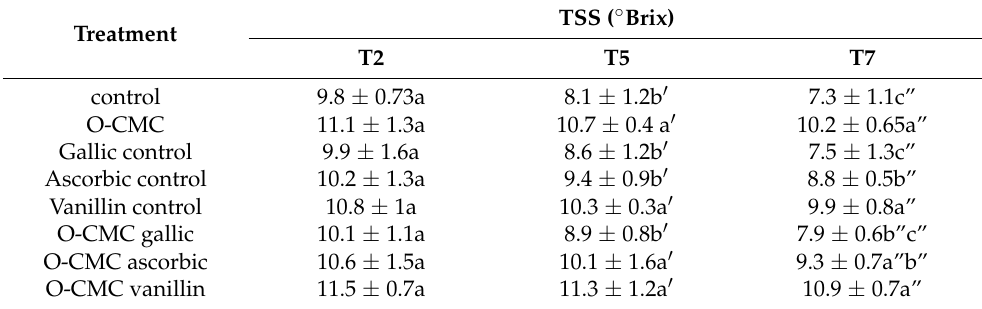
Table 1. TSS values of fresh-cut strawberries with oligo-CMC formulations at three testing times after 2, 5, and 7 days (t2, t5, and t7, respectively) as the means of three replicates. Values followed by a different letter in each tested day (a–c, a’–c’, and a”–c”) within the same sampling time are significantly different according to Tukey HSD test at p ≤ 0.05.